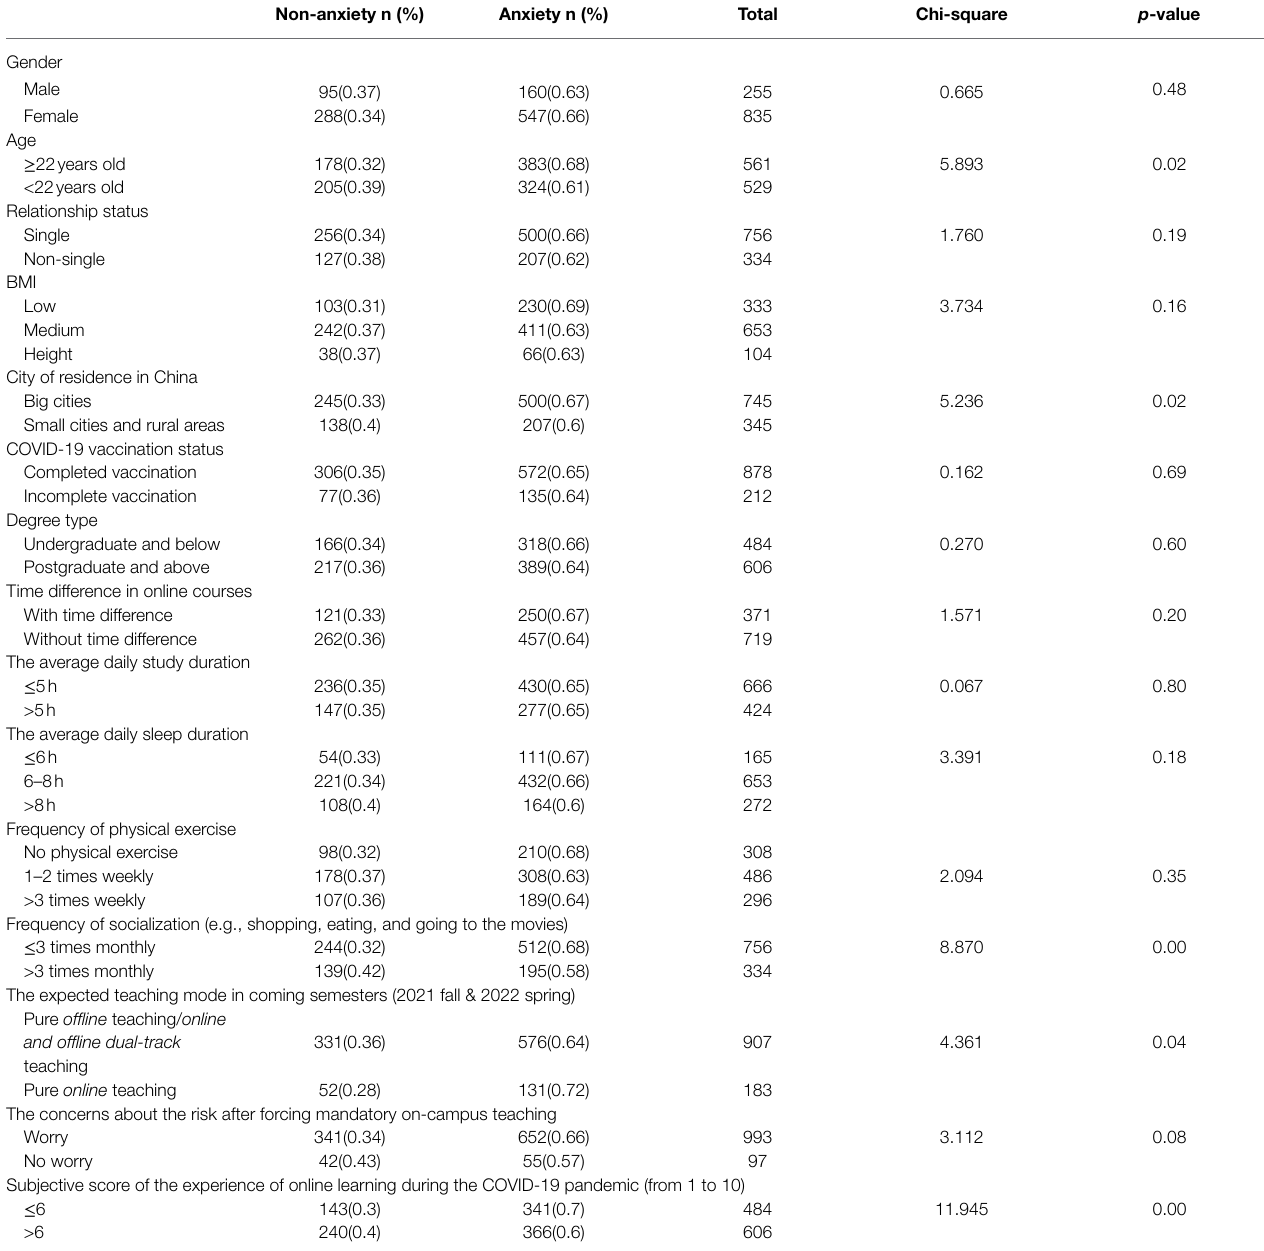
TABLE 2 | Analysis of influencing factors on the incidence of anxiety during online courses for international students. Non-anxiety n